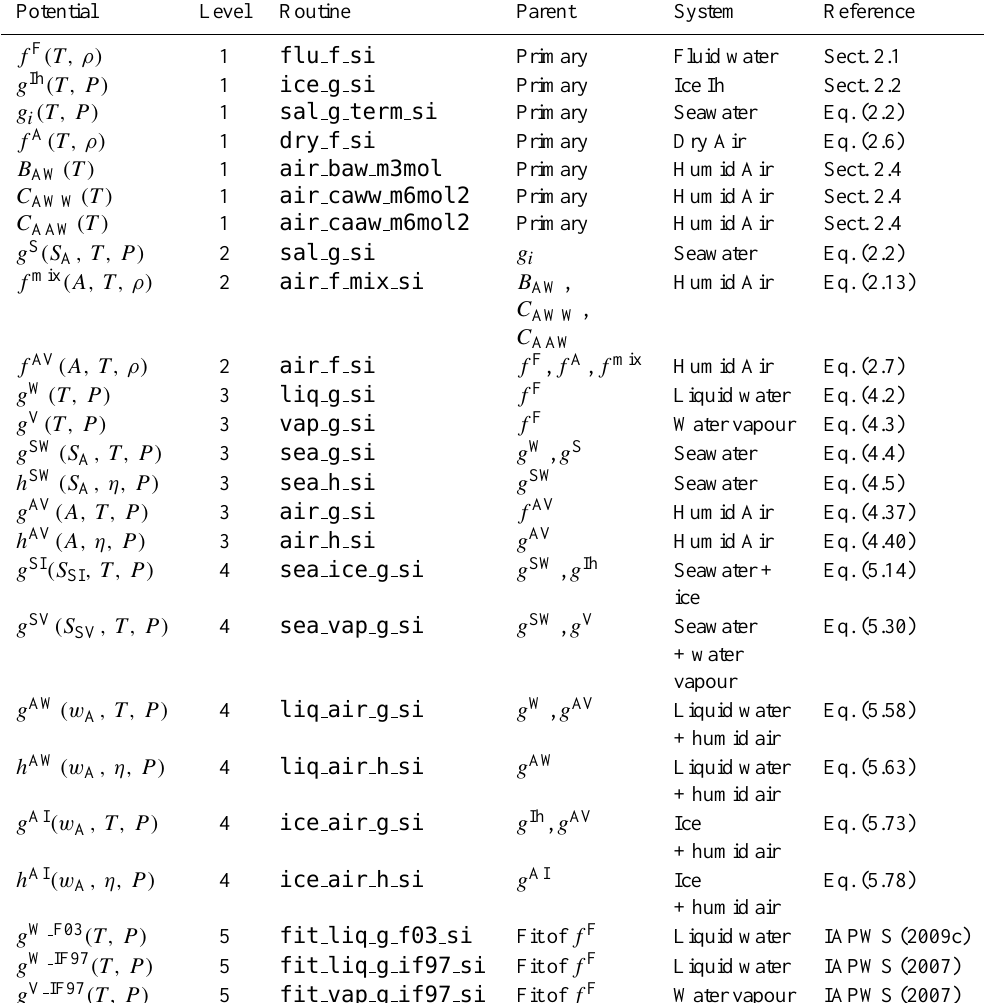
Table 1. Hierarchy of thermodynamic potentials and their elementary constituents implemented in the library. Potential Level Routine Parent System